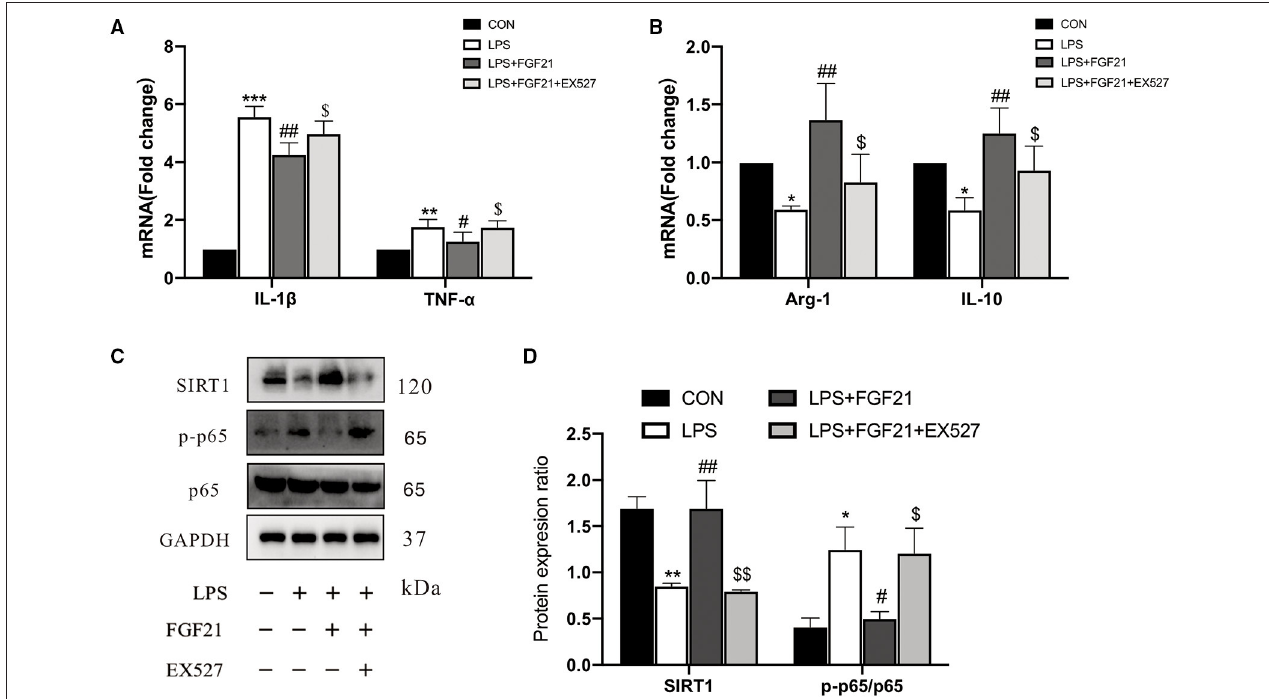
FIGURE 6 | The inhibitory effects of FGF21 treatment on neuroinflammatory response were reversed by SIRT1 inhibitor (EX527). (A,B) Marker of M1 and M2 microglia in BV2 cells in response to FGF21 with or without SIRT1 inhibitor (EX527). (C) Representative immunoblots of SIRT1, phosphorylated protein (p-p65), p65, and GAPDH in BV2 cells in response to FGF21 with or without SIRT1 inhibitor (EX527). (D) Quantification of SIRT1 and p-p65 levels normalized to GAPDH. Data are mean ± s.e.m, n = 3 samples. A one-way ANOVA analysis was conducted followed by an LSD multiple comparison test. * P < 0.05, ** P < 0.01, *** P < 0.001 vs. intact cells; # P < 0.05, ## P < 0.01 vs. LPS-treated cells. $ P < 0.05, $$ P < 0.01 vs. FGF21 + LPS-treated